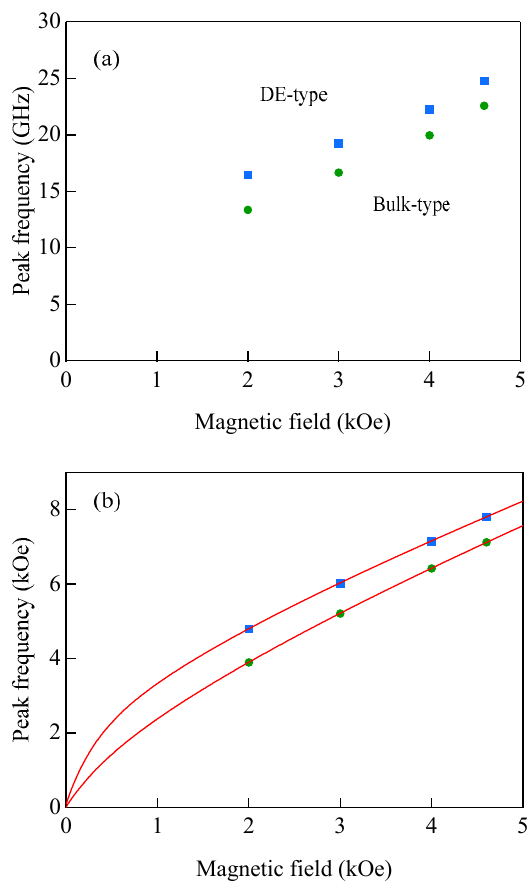
Figure 35. ( a ) FIM peak frequencies obtained from the response function S ( Q // , ω ) with a small damping constant of 0.1 ≤ Γ /2 π ≤ 0.15 GHz as a function of the magnetic field. ( b ) Field dependence of the FIM excitation frequencies divided by γ ( H )/2 π as a function of the magnetic field: ( ● ) bulk-type mode and ( ■ ) DE-type mode. The solid lines show the frequencies calculated by using the right side of Equations (170) and (171) incorporating the 4 π M // ( H ) result [101].